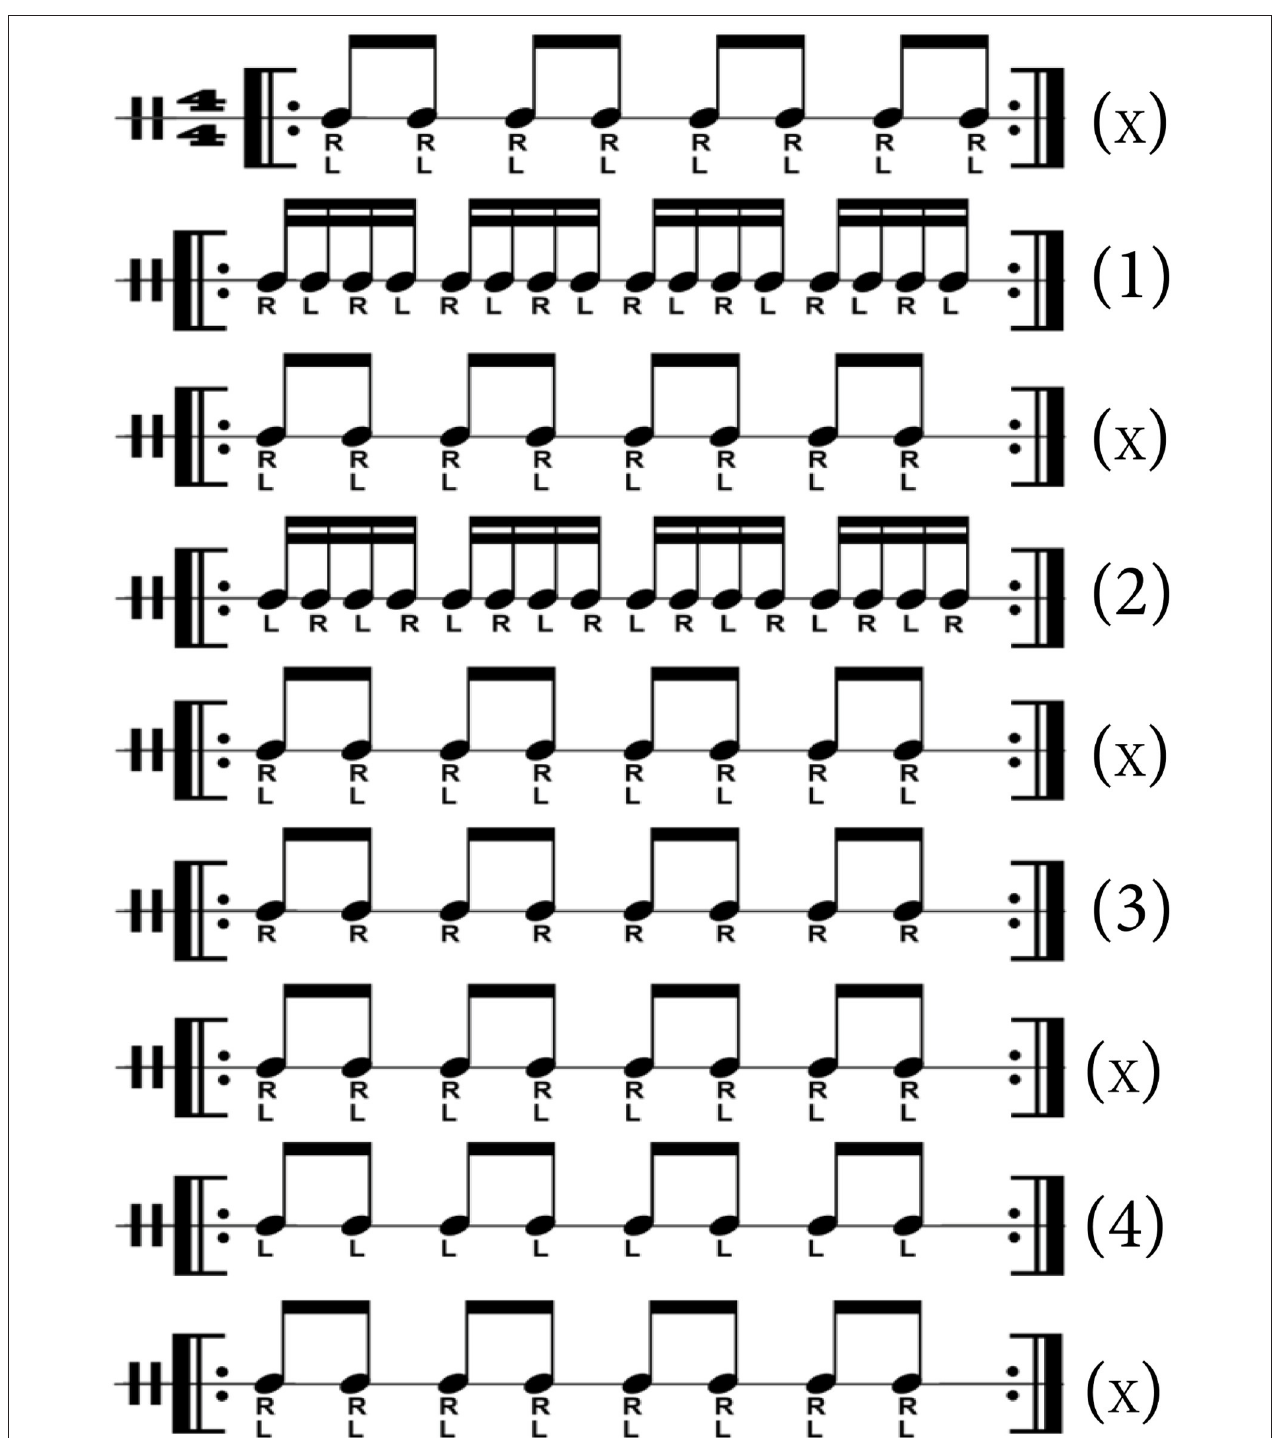
FIGURE A1 | Drum patterns included in the 18-bar exercise (1) both hands alternating (BHRLead), with the right hand leading (i.e., right hand down stroke coinciding with the first beat of a measure), (2) both hands alternating (BHLLead), with the left hand leading (i.e., left hand down stroke coinciding with the first beat of a measure), (3) right hand solo (RHSolo), (4) left hand solo (LHSolo), (X) both hands simultaneously (BH), filler condition.